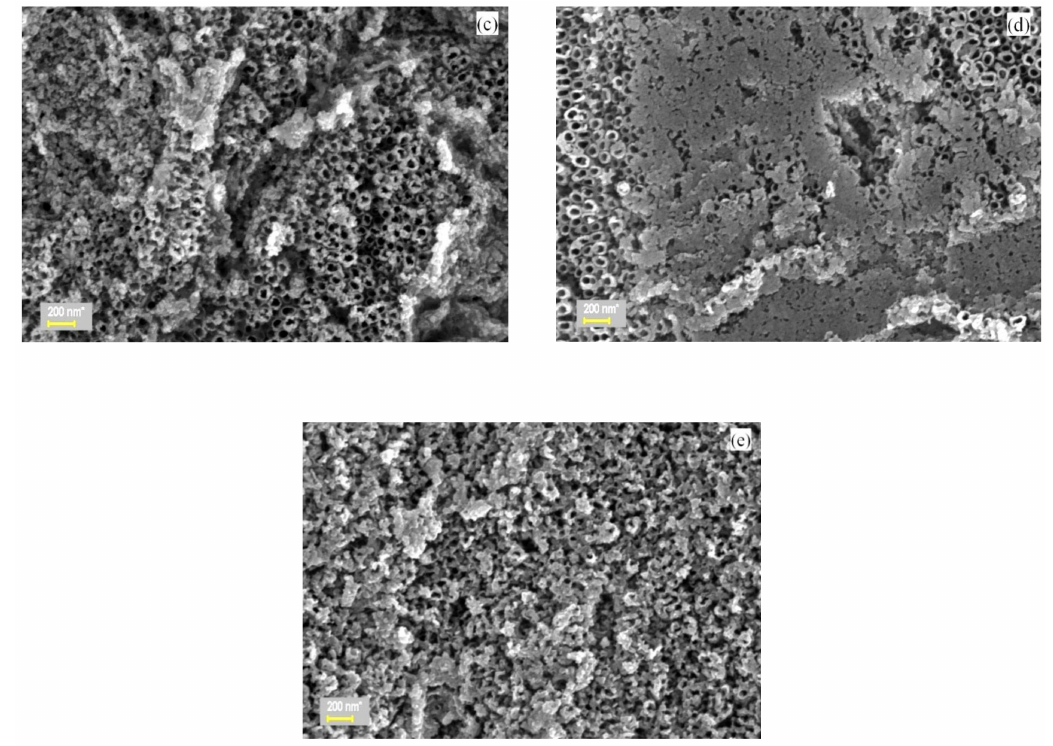
Figure 1. SEM images of: ( a ) the top and ( b ) cross-section surfaces of the TZN_0 sample. Top view of